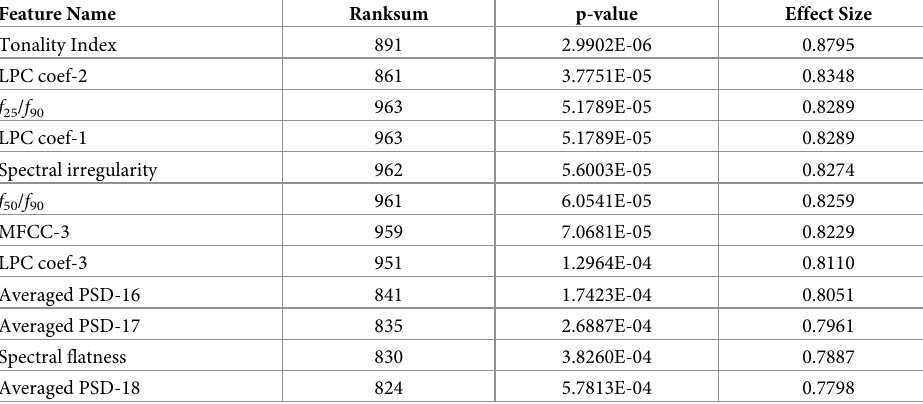
Table 7. Features with highest effect size using ranksum